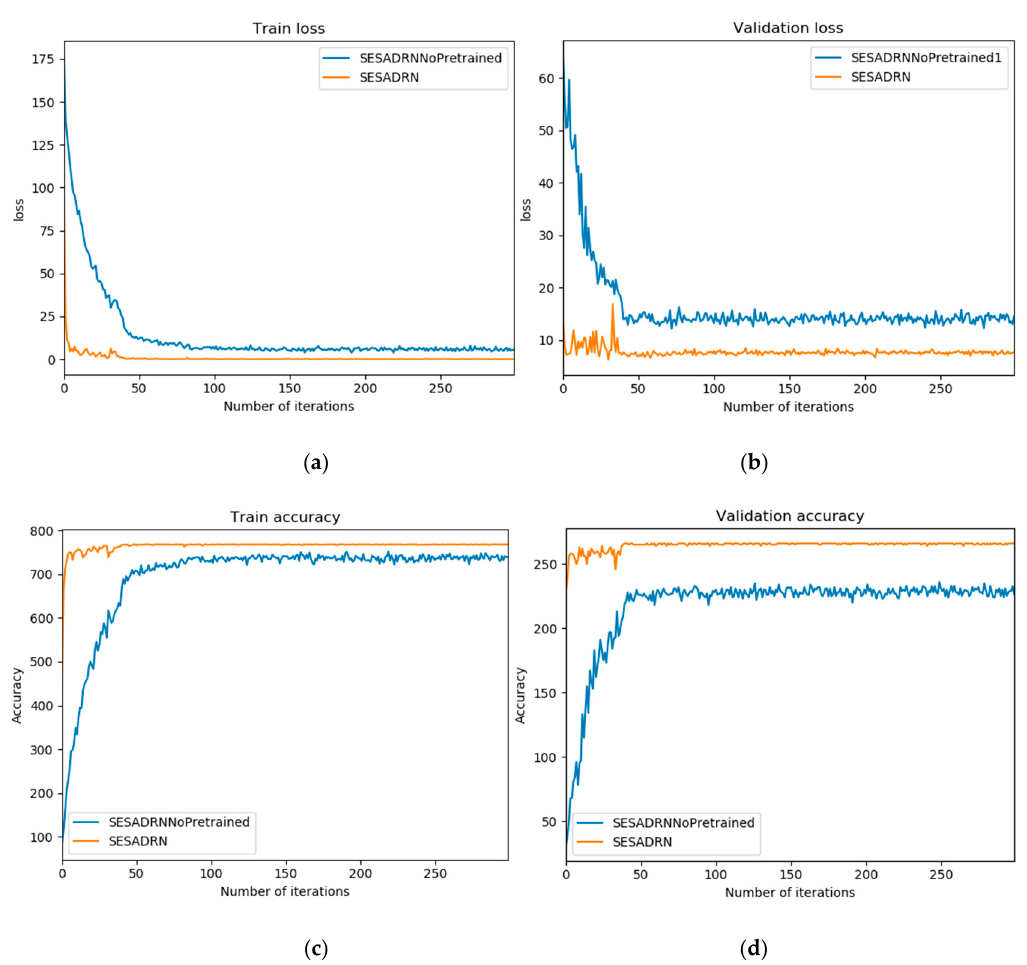
Figure 7. Accuracy and loss of training and validation (SESADRNNoPretrained, SESADRN). ( a ) Training loss of 300 epochs. ( b ) Validation loss of 300 epochs. ( c ) Training accuracy of 300 epochs. ( d ) Validation accuracy of 300 epochs.